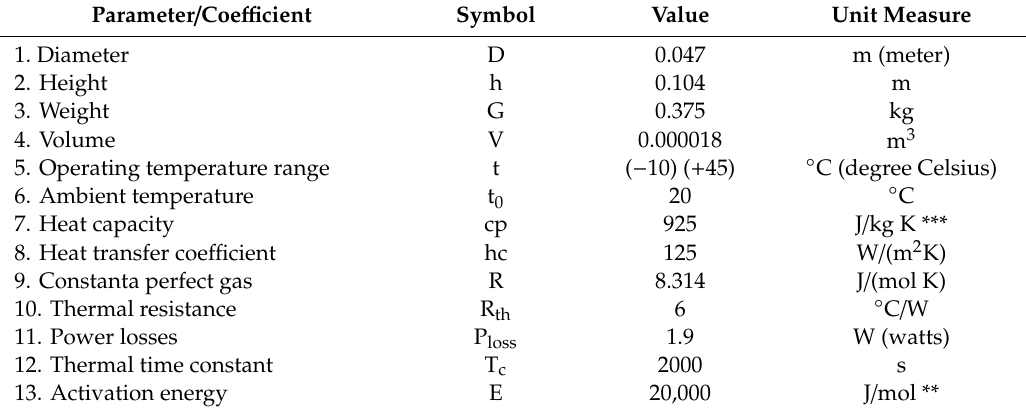
Table 2. Li-ion mechanical and thermal characteristics SAFT battery of 6 Ah, 3.6 V (cylindrical shape) [16]. Figure 2. Vehicle input page setup. Parameter / Coe ffi cient Symbol Value Unit Measure